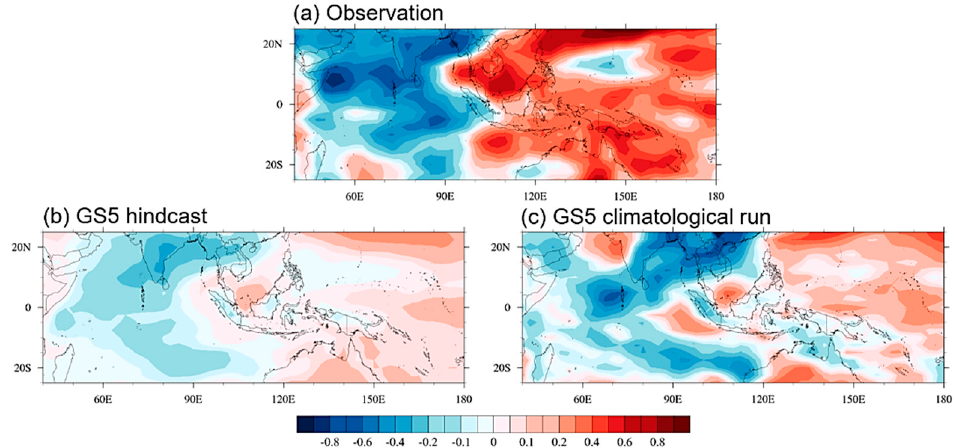
Figure 8. The regressed 20–70-day filtered convective instability (°C) onto filtered precipitation (20–70 days) averaged over the eastern Indian Ocean (10° S–10° N, 80°–100° E) from ( a ) observation, ( b ) GS5 hindcast data, and ( c ) GS5 climatological run. The strengths of regression are fixed to a 3 mm day − 1 . The convective instability is defined as EPT at 850 hPa minus EPT at 400 hPa.